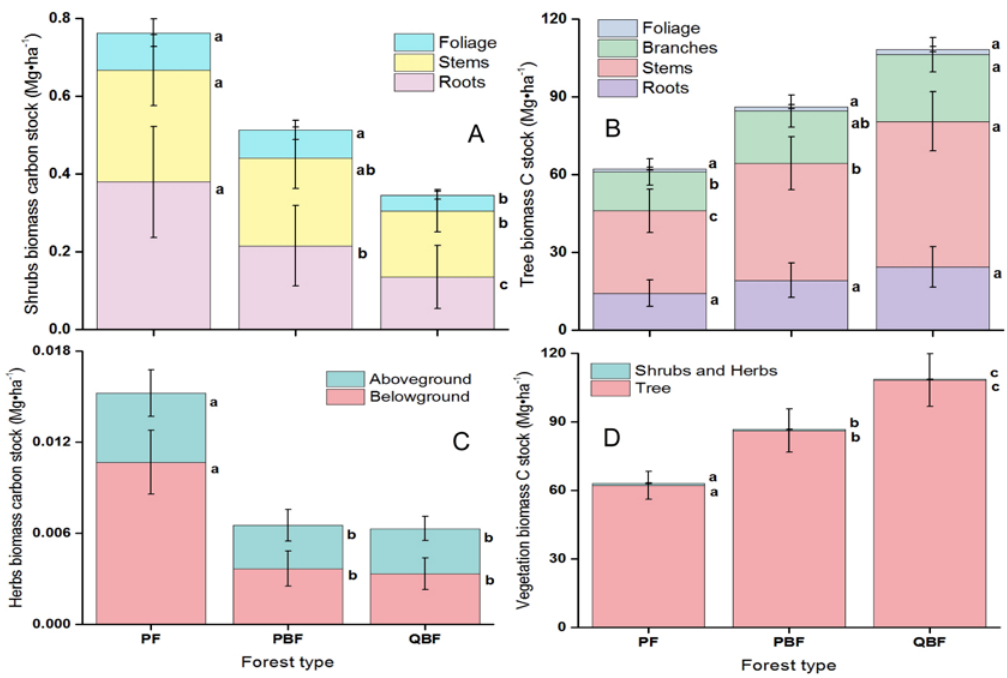
Figure 2. The vegetation biomass carbon stocks of the various components in the pure Pinus tabuliformis forest (PF), pine-broadleaved mixed forest (PBF) and Quercus -broadleaved mixed forest (QBF) in the central Loess Plateau of China. ( A – D ) illustrate the tree, shrub, herb, and vegetation carbon stocks, respectively. a, b, and c indicate significant di ff erences in the carbon stocks of the same components at di ff erent succession stages at p =